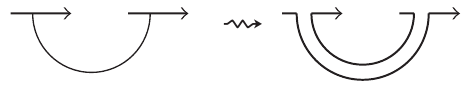
Figure 7.2 . A special picture of a chord diagram.